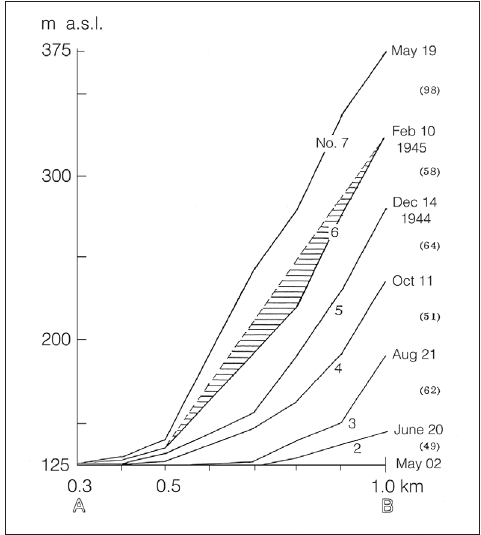
Fig. 10. Northern half of pseudo growth curves. Letter BB is the center of dome. Hatched part indicates the excess expansion of dome between survey nos. 6 and 7. Parenthesized numerals indicate the intervals in day between the surveys; the magma ascended rather smoothly until survey no.